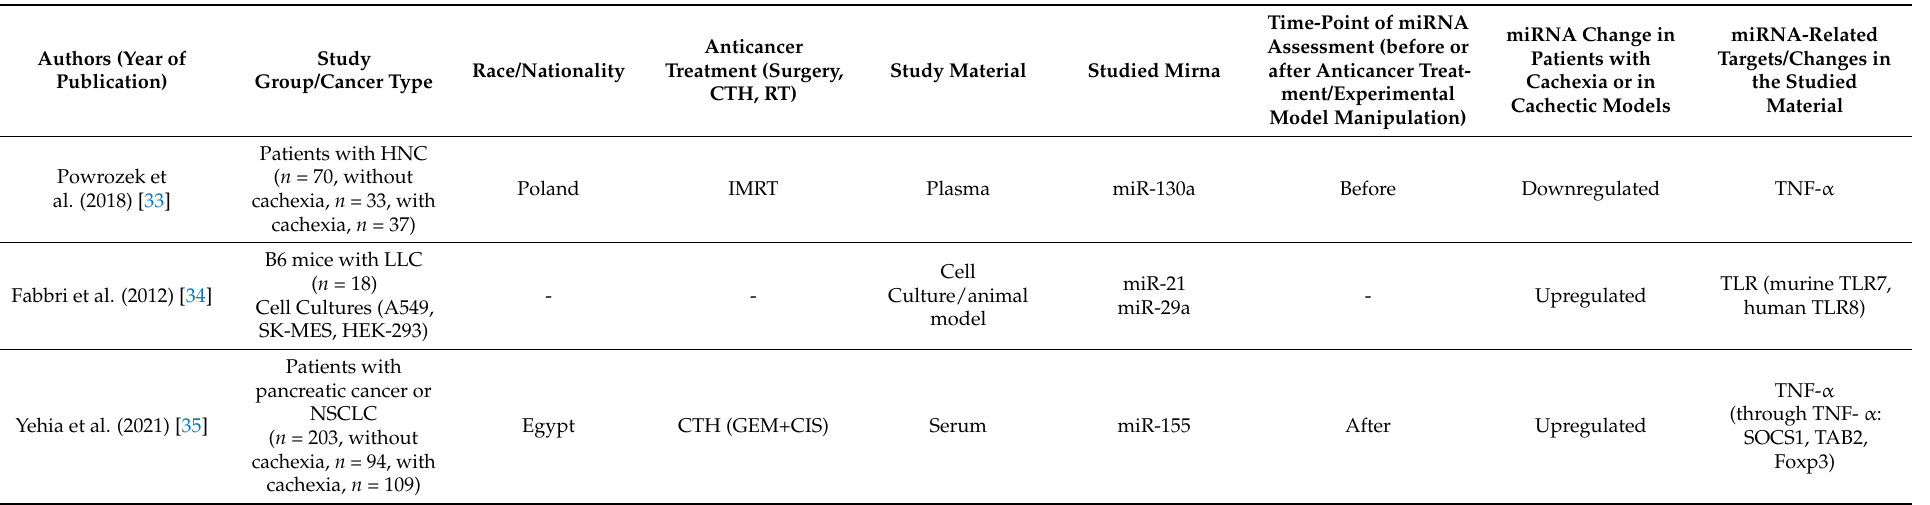
Table 1. The role of miRNAs in the regulation of proinflammatory cytokines involved in cancer